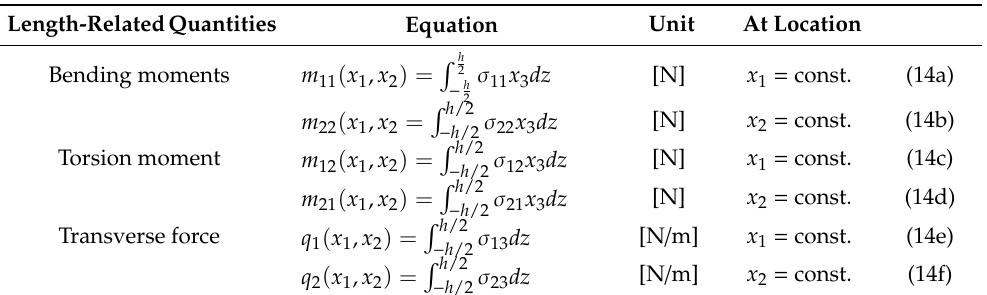
In the equilibrium state, the following equations apply for the forces and moments: Table 1. Bending moments, torsional moments, transverse forces, and the corresponding